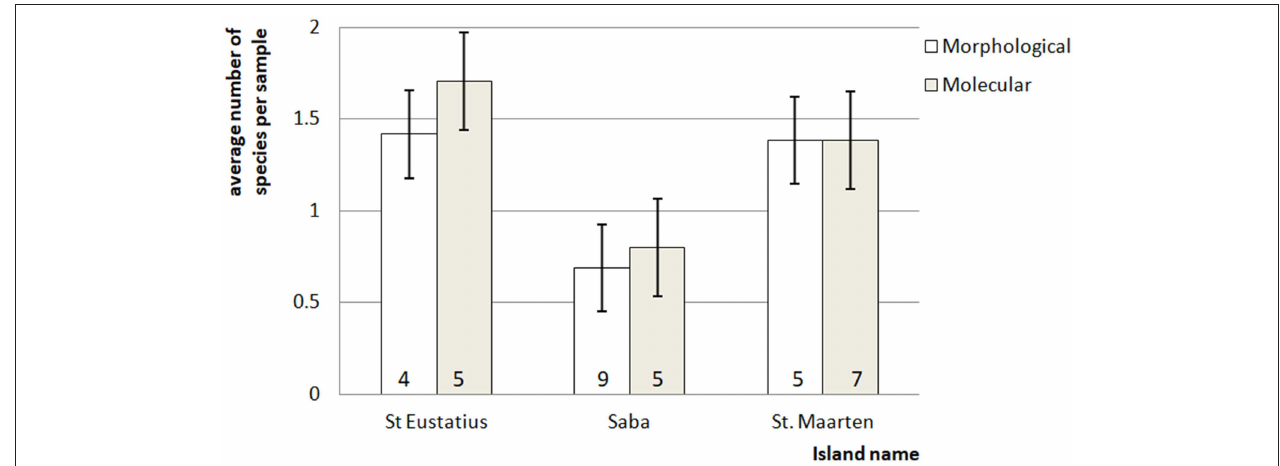
FIGURE 2 | Average number of mosquito species in the bulk samples ± standard error. The number at the bottom of each bar indicates for each island the total number of species detected for that particular method.